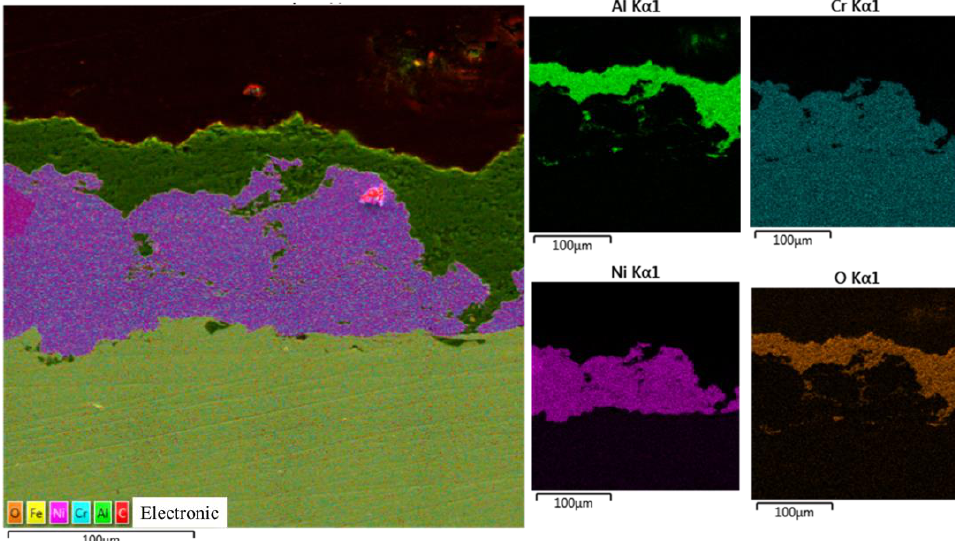
Figure 6. SEM images of the cross-sectional morphology of the three-layer gradient coating. By studying the distribution of elements along the cross-sectional line of the coating (Figure 7), it was possible to study the elemental compositions of the layers.